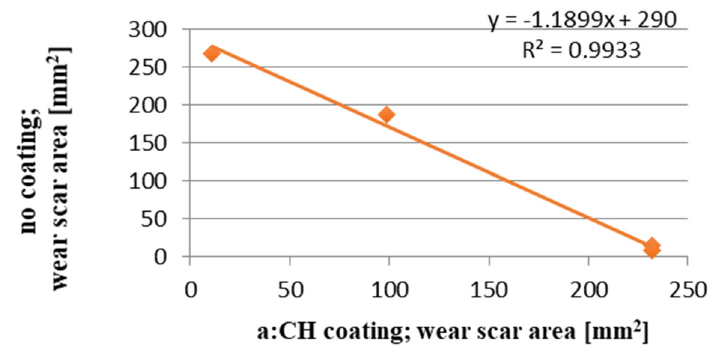
Figure 14. Wear scar area on the coated discs vs. wear scar area on the uncoated ones.